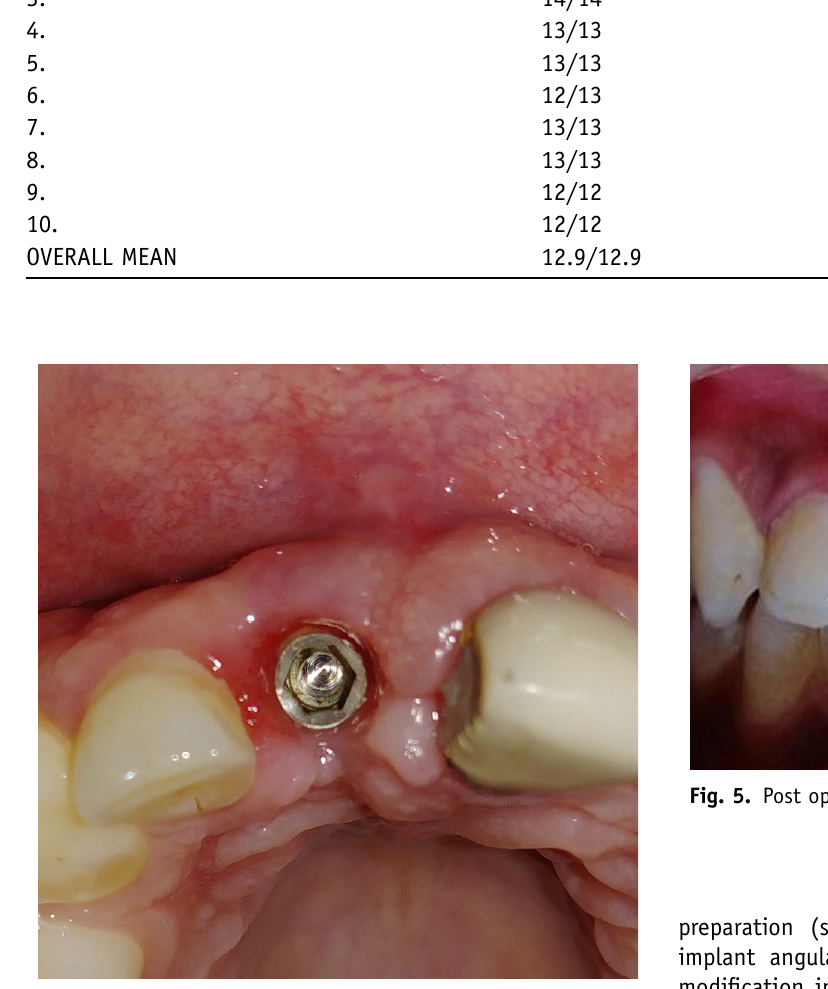
Fig. 4. Healed peri implant mucosa showing socket shield and implant. (Note the thick prototype of mucosa).